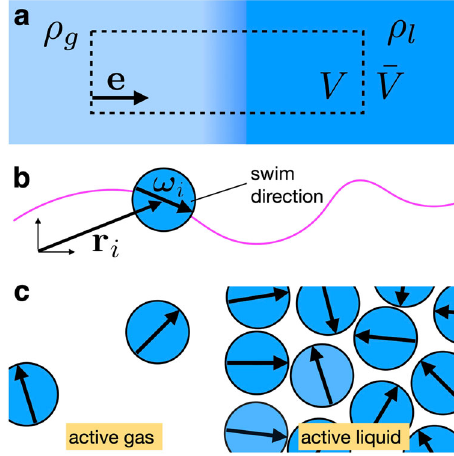
Fig. 4 Phase separation into macroscopically distinct phases. a Illustration of the geometry of phase separation of passive or active particles. Shown are the gaseous ρ g and liquid ρ l plateau values of the density pro fi le (indicated by the color gradient) and the direction vector e normal to the interface. The total system volume V þ (cid:2) V consists of the subvolume V and its complement (cid:2) V . b Illustration of an active Brownian particle (blue disc) with position r i and orientation ω i undergoing translational and rotational diffusion. The self propulsion along ω i creates directed motion as indicated by the trajectory (magenta line). c Schematics of motility-induced phase separation into active gas (left) and active liquid phases (right). The arrows indicate the orientations ω i of the active particles. The interface is